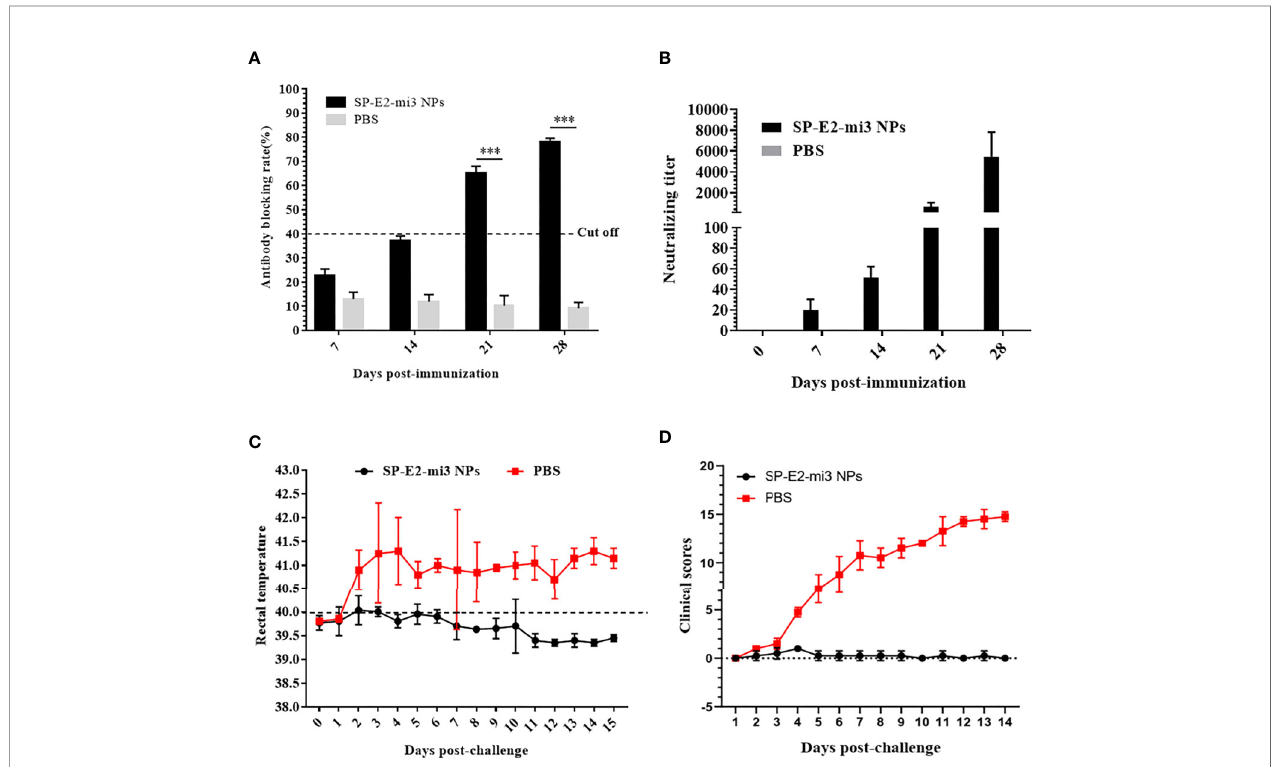
FIGURE 8 | Protective ef fi cacy elicited by single dose of SP-E2-mi3 NPs in pigs. three groups (n = 4) of 4-week-old piglets were intramuscularly inoculated with 10 m g SP-E2-mi3 NPs, 10 m g SP-E2 and PBS, respectively. The remaining group was left untreated. (A) Detection of CSFV-speci fi c antibodies in serum samples collected at the indicated time points using the IDEXX HerdChek ® CSFV Antibody Test Kit. (B) Detection of CSFV neutralizing antibody in pig serum samples. Neutralization titer was determined against CSFV Shimen strain. (C) Rectal temperatures of the piglets following CSFV lethal challenge. (D) Clinical scores were evaluated based on fi ve CSFV-induced typical clinical symptoms, and the data was collected daily. ***p < 0.001.